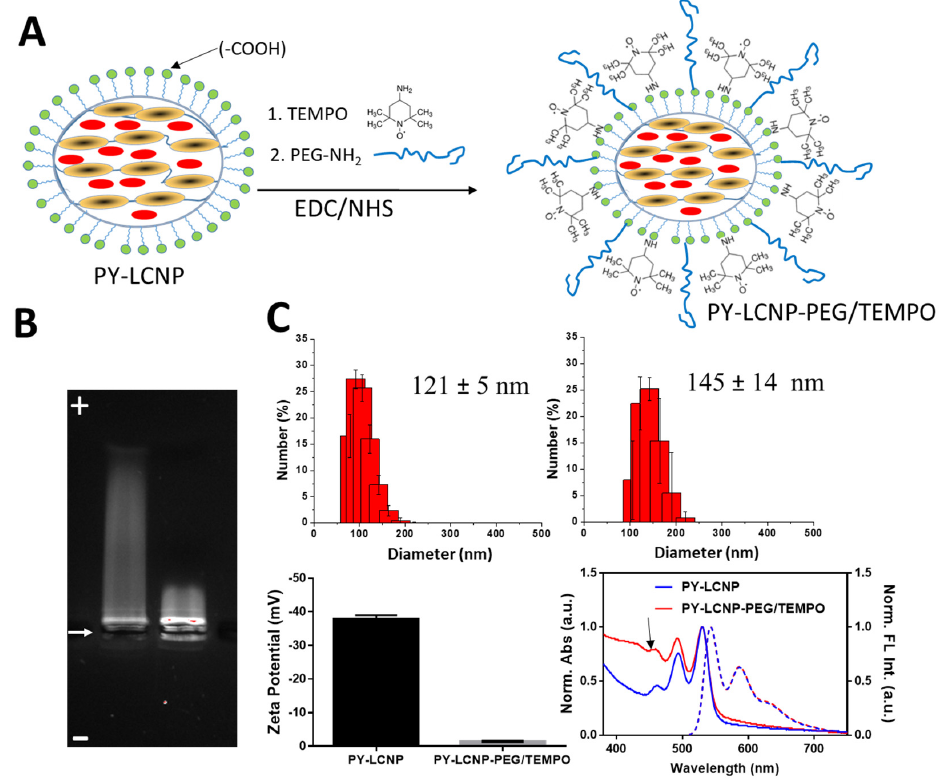
Figure 1. Synthesis and physicochemical characterization of PY-LCNP-PEG/TEMPO . ( A ) Schematic of the perylene (PY, red oval)-loaded liquid crystal nanoparticle (PY-LCNP) and EDC conjugation to TEMPO and PEG 2000 -NH 2 . Yellow ovals represent the liquid crystal crosslinker, DACTP11. ( B ) Image of the gel electrophoresis (1% agarose) of the PY-LCNPs. The arrow indicates the location of the sample-loading wells. Unconjugated PY-LCNP (left) migrate further towards the cathode (+) compared to the PEG/TEMPO-conjugated PY-LCNP (PY-LCNP-PEG/TEMPO). ( C ) Distribution plots depicting hydrodynamic size via DLS for PY-LCNPs (top left) and PY-LCNP-PEG/TEMPO (top right), with average diameter (± standard error of the mean (SEM)), zeta potential (bottom left), and UV-Vis absorbance (solid lines) and fluorescence emission (dashed lines) spectra of the PY-LCNPs and PY-LCNP-PEG/TEMPO (bottom right). The arrow indicates the characteristic absorption peak of TEMPO at ~426 nm. The fluorescence emission spectra were collected by excitation at 488